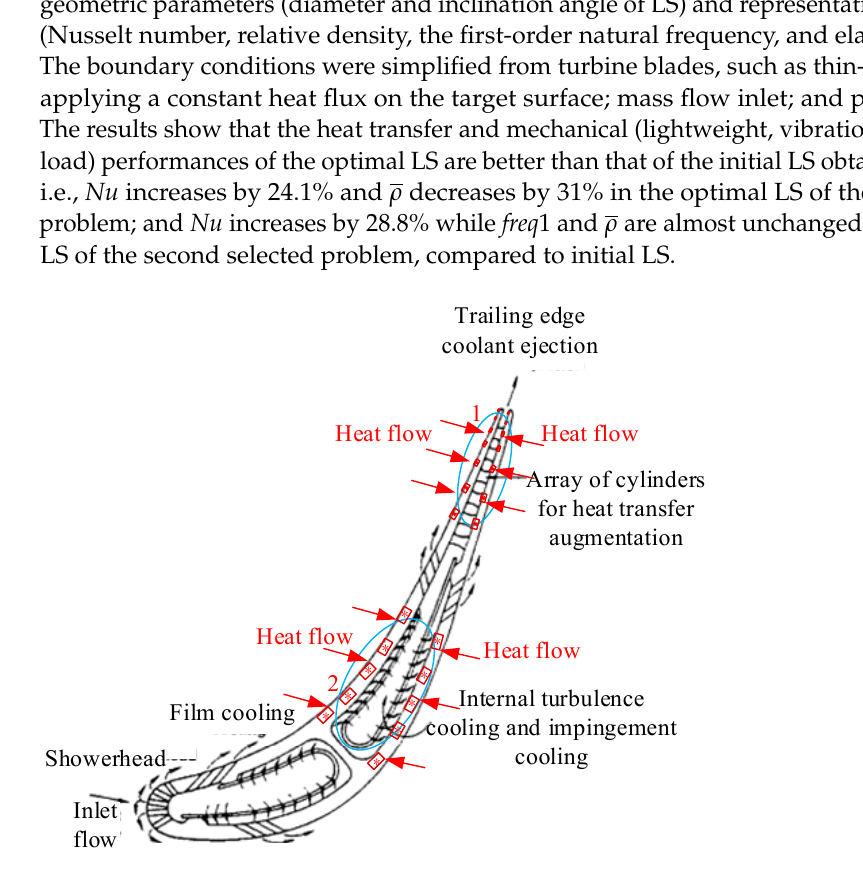
Figure 1. Schematic of cooling arrangement in a turbine blade.